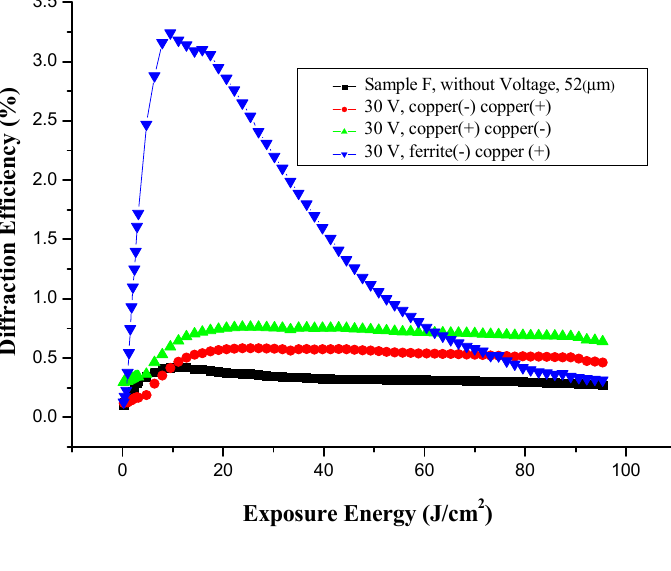
Figure 17. Diffraction efficiency of 30 V voltage with thickness of 52 µm of sample F with a frequency of 1132 lines/mm, using different